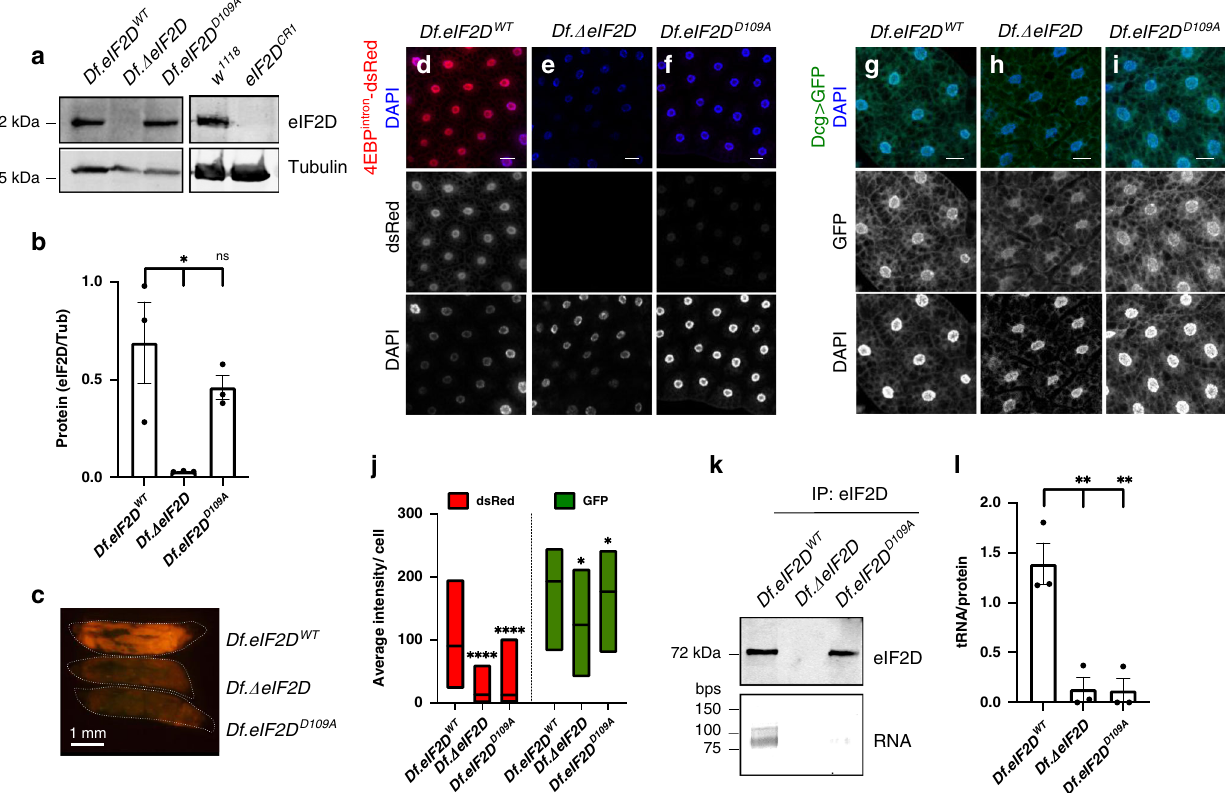
Fig. 2 eIF2D is required for ATF4 expression and ISR signaling. a Western blot analysis of larval extracts from various allelic combinations of eIF2D mutants. w 1118 is the isogenic wild type control for eIF2D CR1 . b Quantitation of data from western blots in a representing the mean of three independent biological replicates with error bars representing standard error. c Expression of 4E-BP intron -dsRed in control larvae ( Df.eIF2D WT ), eIF2D deletion mutant ( Df. Δ eIF2D ) and an eIF2D mutant where the tRNA-binding interface is disrupted ( Df.eIF2D D109A ). Individual larvae are shown in dotted outlines. d – f Fat body tissues dissected from larvae in c showing 4E-BP intron -dsRed (red), and counterstained with DAPI (blue). g – i Fat body tissues from larvae of indicated genotypes expressing GFP (green) driven by the fat body speci fi c driver, Dcg-GAL4 , and counterstained with DAPI (blue). j Quantitation of fl uorescent protein intensity from individual cells in d – f and g – i . Midline represents the mean value, with the top and bottom of the box representing the maximum and minimum values. Asterisks above boxes represent statistical signi fi cances between mutant and control values. n = 278, 341, 231, 213, 335, and 395, respectively for each box from left to right. k Analysis of eluates from immunoprecipitation of eIF2D. Top panel shows western blot analysis of eluates and bottom panel shows TBE-UREA gel analysis of bound RNA. l . Quanti fi cation of data from k representing the mean of four biological replicates, with RNA levels for each sample normalized to respective protein levels. Data in c – i are representative images collected from two independent biological experiments with ten animals in each trial. Statistical signi fi cance in b , j , and l were calculated using the two-tailed t-test with **** p < 0.00001, ** p < 0.001, * p < 0.01 and n.s. not signi fi cant. Please see Source Data Files for the raw data in a , b , j , k , l western blots (Fig. 2a, b). Consistent with the RNAi data, eIF2D